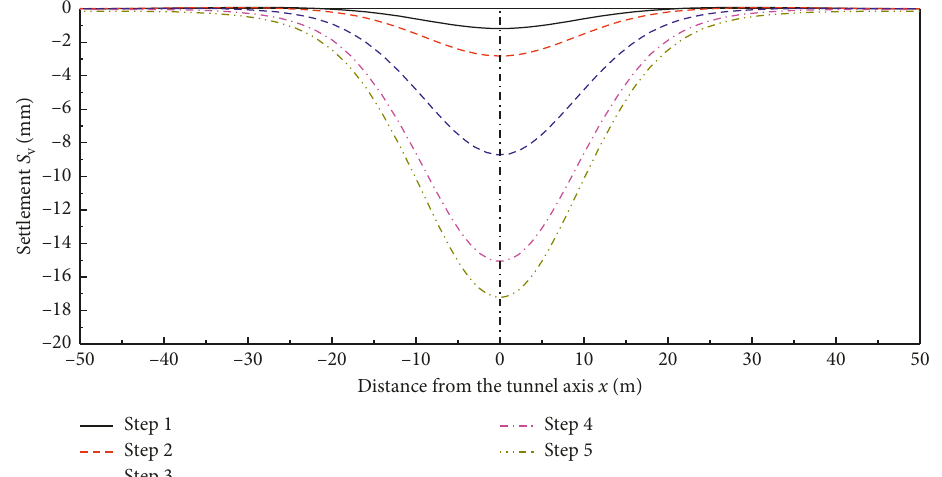
Figure 13: Numerical results of settlements at the ground surface during tunnelling.